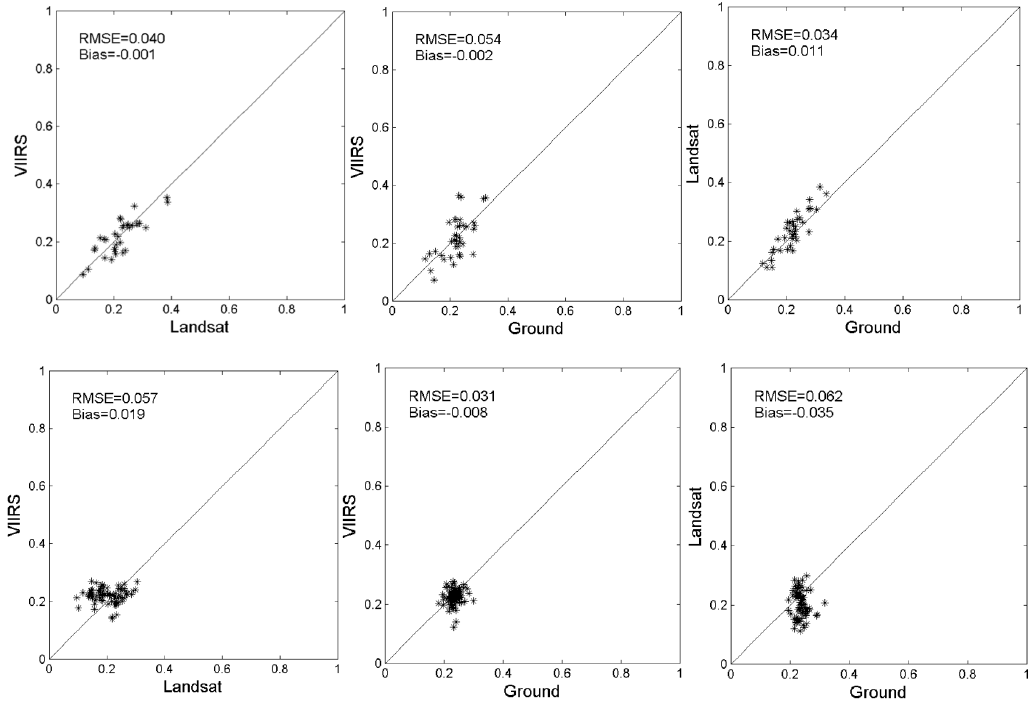
Figure 6. Cont. Figure 6.